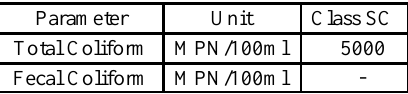
Table 1. Standard Value of Class SB and SC Water Classification